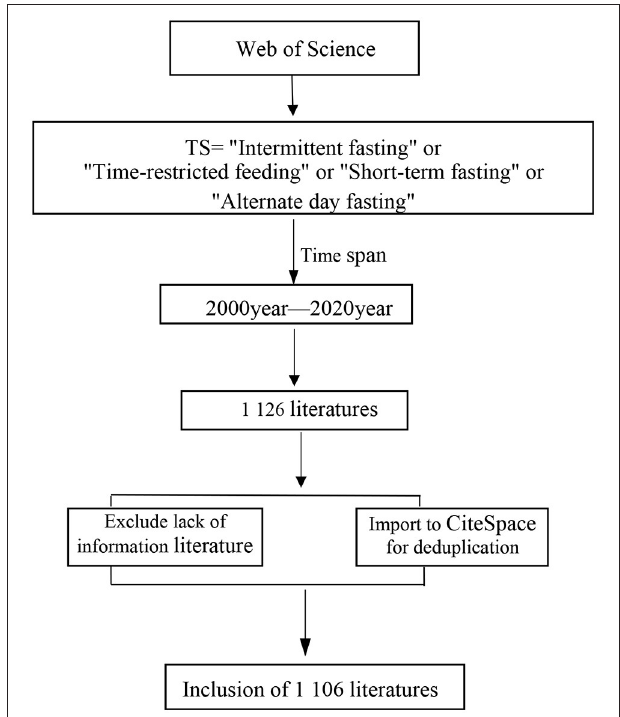
FIGURE 1 | The flow chart of searching papers in